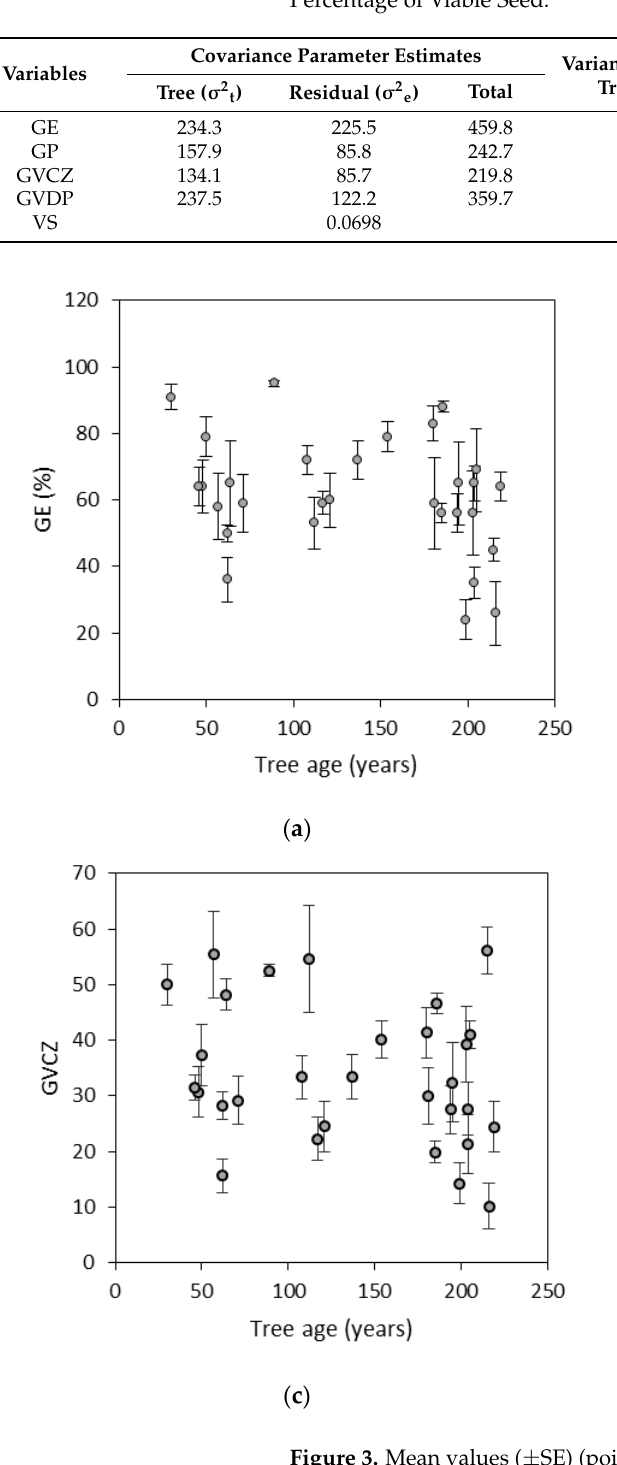
Table 4. Between-Tree Variability and Effect of Tree Age on Germination Parameters and Seed Viability. GE: Germination Energy. GP: Germination Percentage. GVCZ: Germination Values according to Czabator. GVDP: Germination Value according to Djavanshir and Pourbeik. VS%: Percentage of Viable Seed.